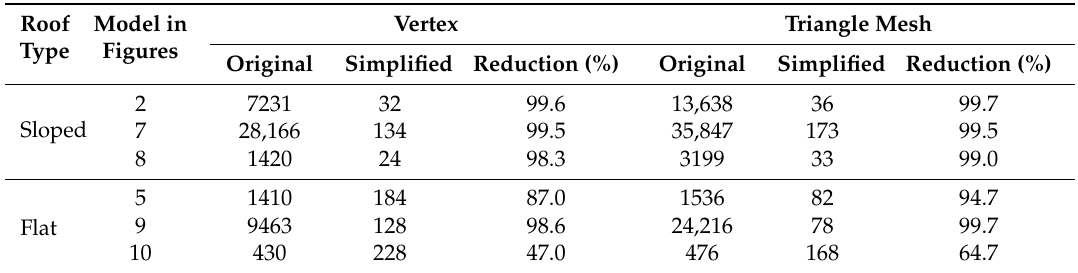
Table 1. Data volume comparison for original and simplified 3D building in